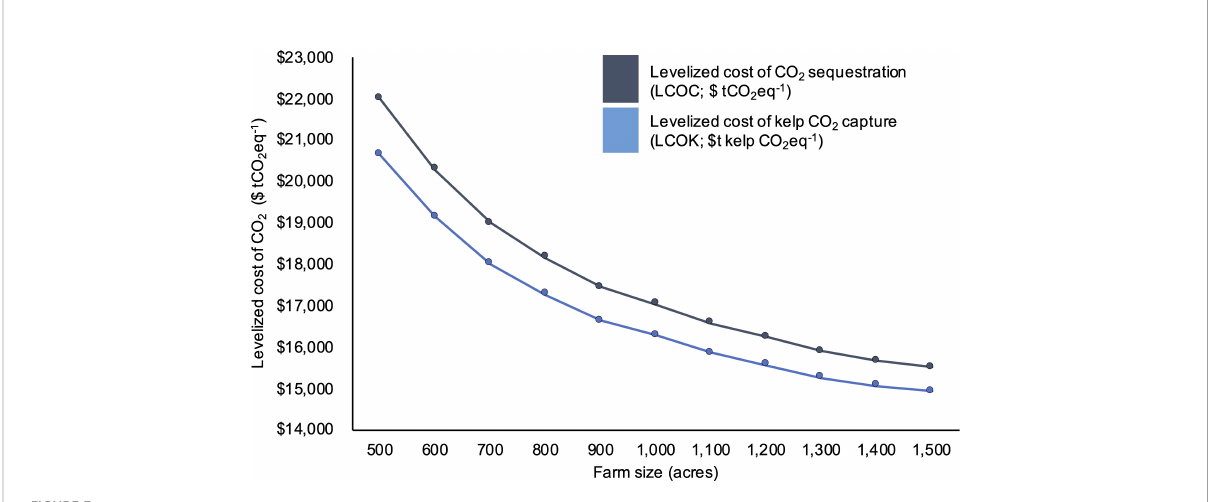
FIGURE 3 Levelized cost of sequestering a single ton of CO 2 eq ($ tCO 2 eq -1 ; LCOC; dark blue line ) and levelized cost of capturing a single ton of CO 2 eq within kelp biomass prior to transport, veri fi cation, and permanent sequestration ($ tCO 2 eq -1 ; LCOK; light blue line ) as a function of farm size